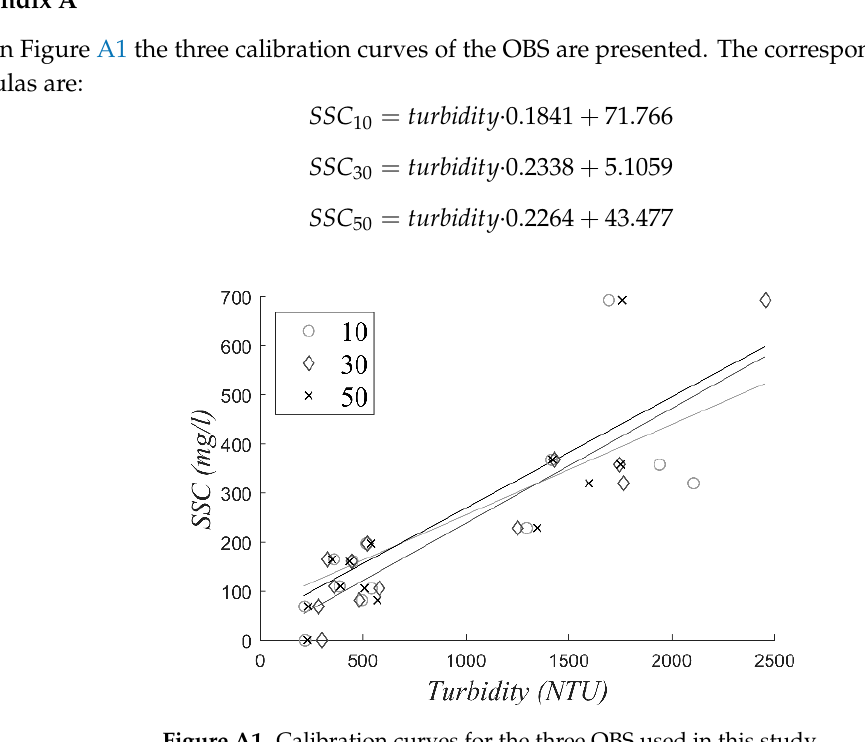
Figure A1. Calibration curves for the three OBS used in this study.